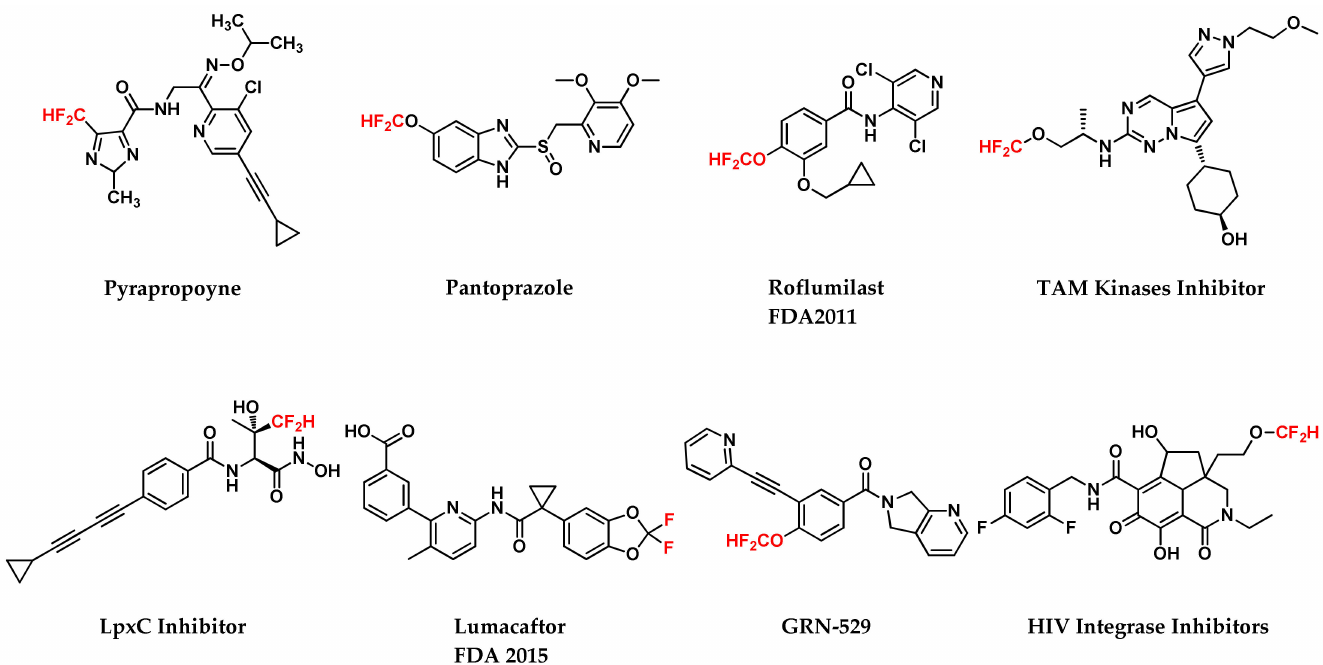
Figure 1. Selected examples of CF 2 H-containing pharmaceuticals and drug candidates over the past two